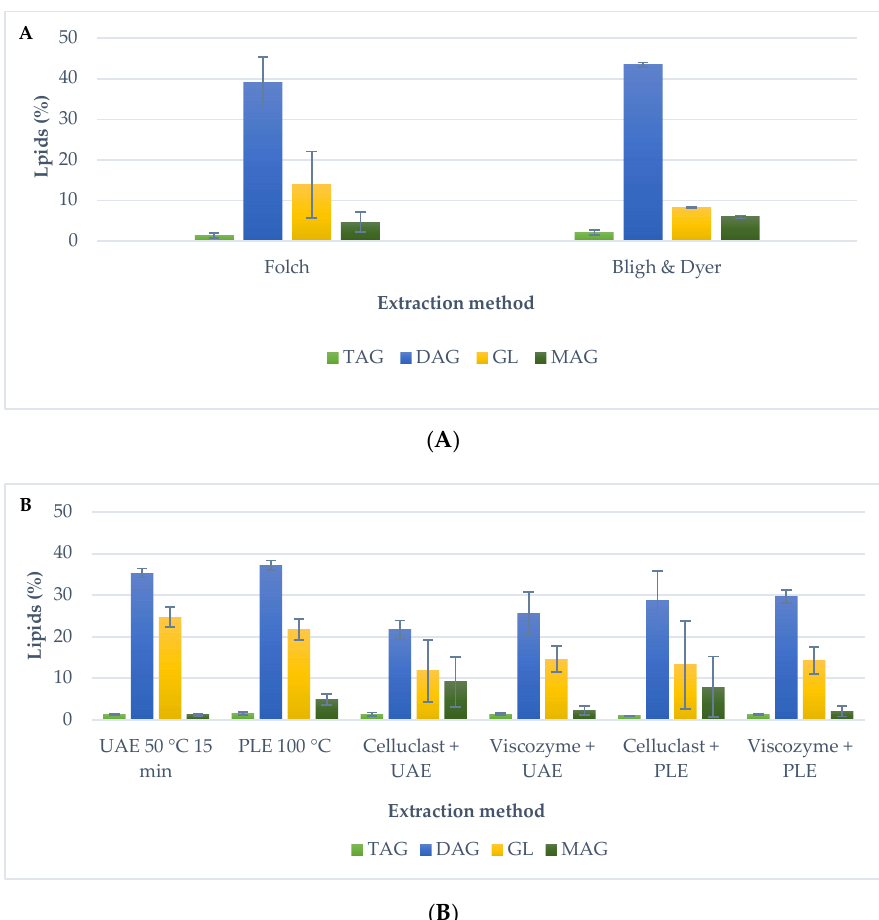
Figure 4. TAG, DAG, GL and MAG content obtained by different techniques. ( A ) Traditional methods Folch and Bligh and Dyer and ( B ) advanced extraction techniques at the optimal extraction condition and enzyme pre-treatment and not.